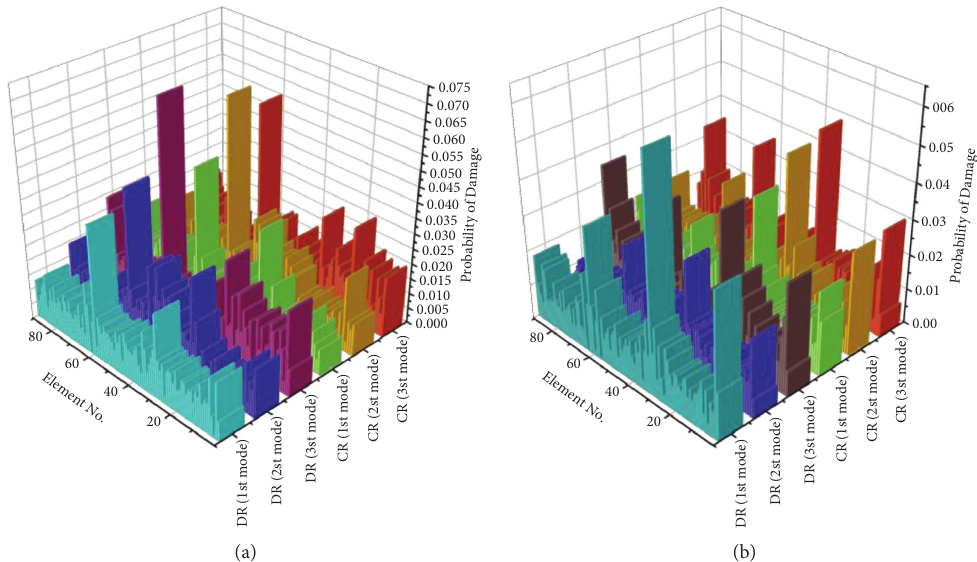
Figure 22: Damage identification results for case21 (a) and case22 (b) of single